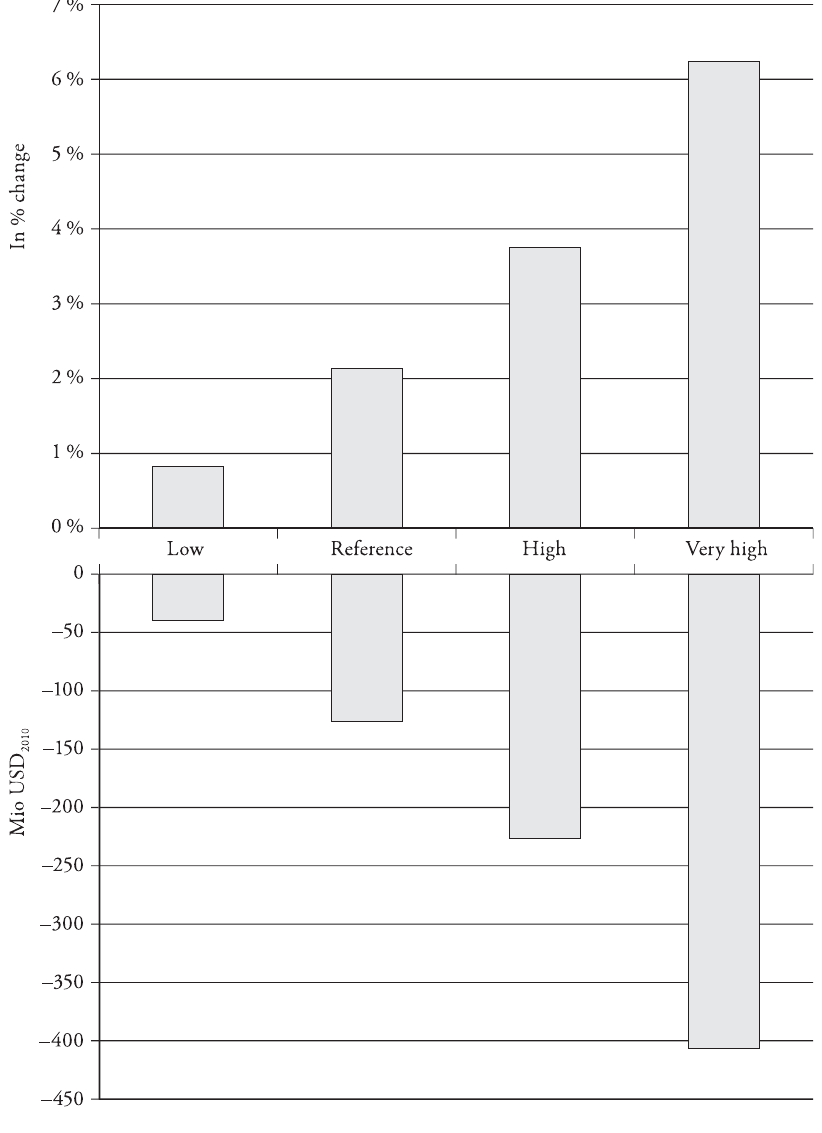
Figure 6: Electricity Consumption Changes in % (top) and Welfare Change in Mio USD (bottom) under Climate Scenario AlB with Respect to the 2010